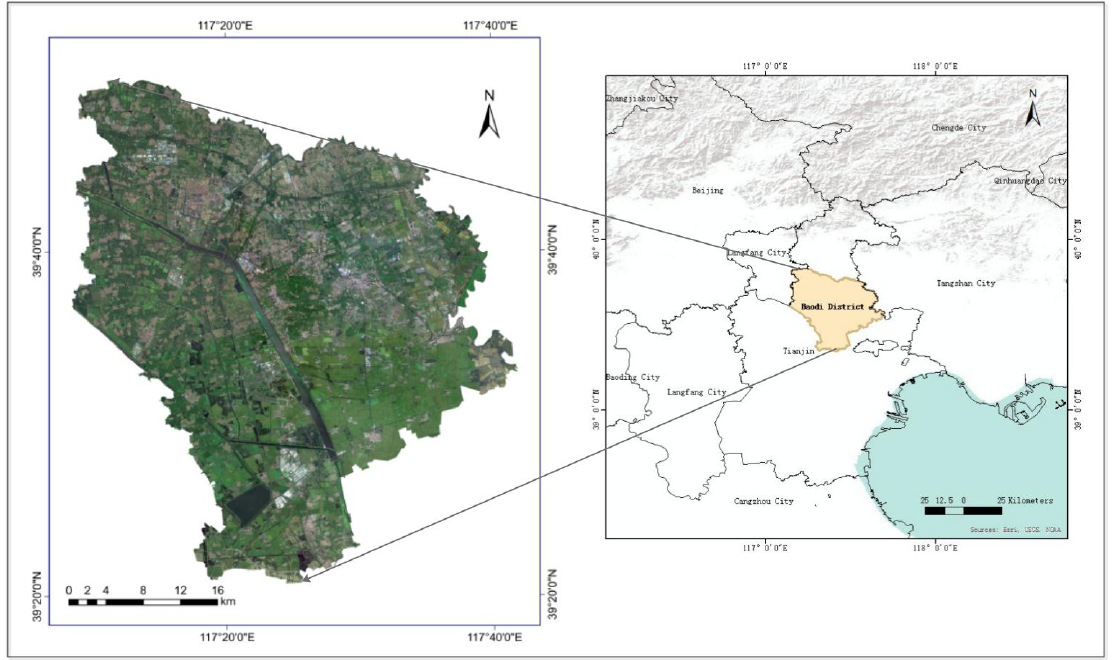
Figure 1. Baodi county with its WorldView-2 (WV-2)